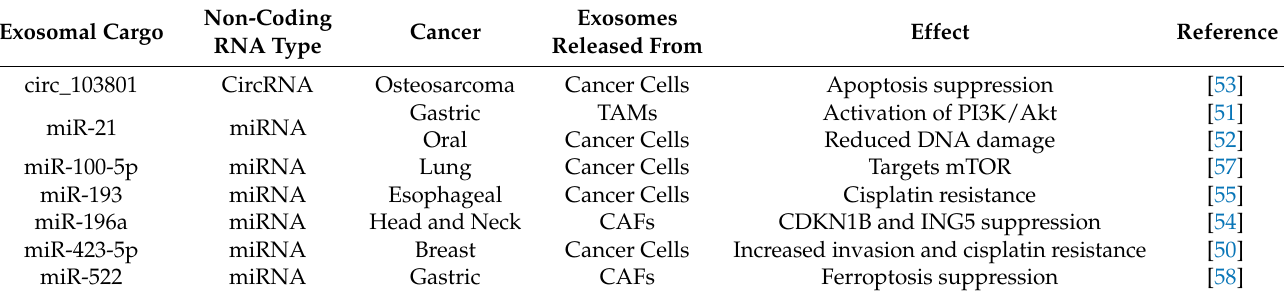
Table 2. Exosome-mediated cisplatin